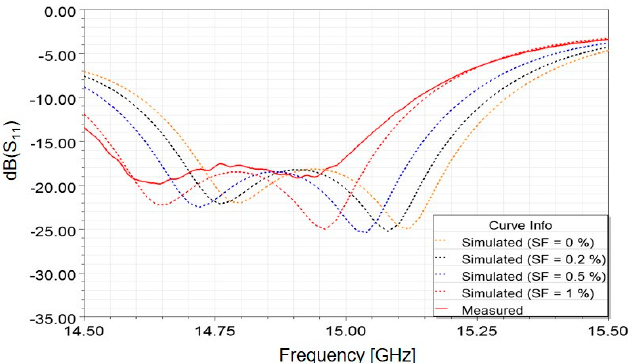
Figure 8. Comparison between simulations and measurement of the reflection coefficient |S 11 | of the 16-slot waveguide antenna for different scale factors (SFs).